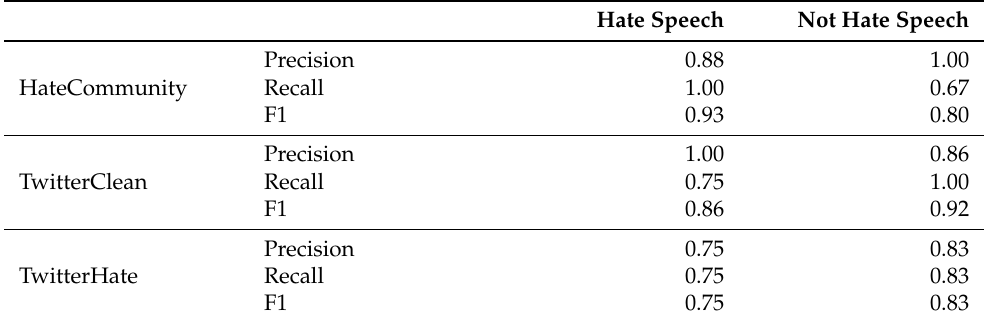
Table 4. Aggregate annotator